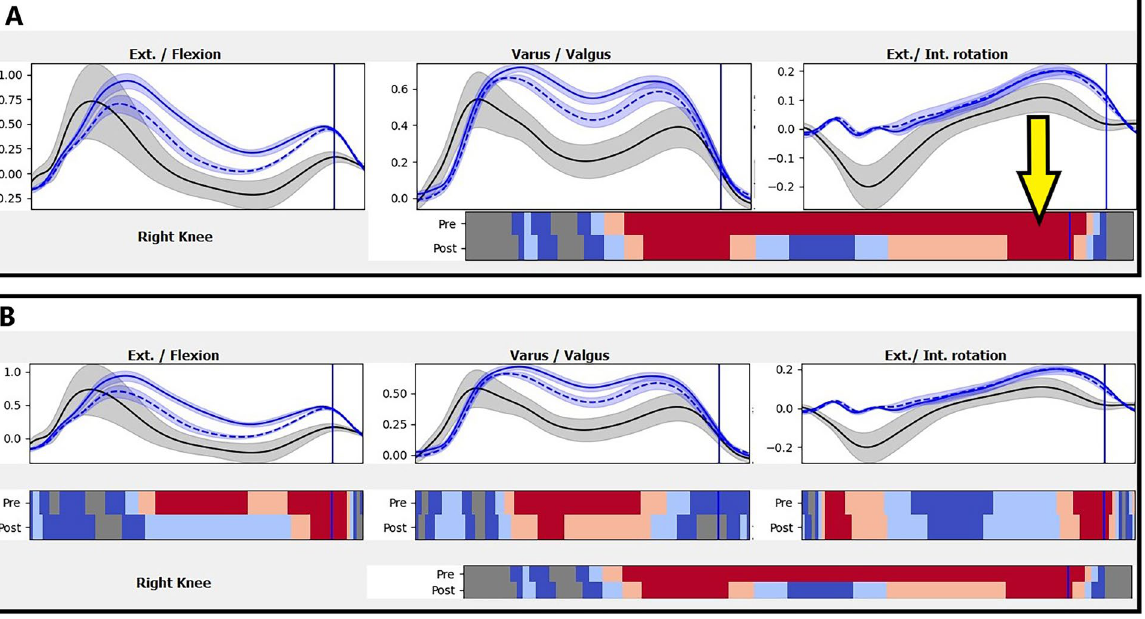
Figure 4. Close view of the right knee. ( A ) with hidden individual components. 1st row shows the recordings (reference, pre, and post intervention) in 3 dimensions. 2nd row shows the result of comparisons of both the preintervention vector (above) and postintervention vector (below) to the reference data vector, using Hotelling’s 2 test. The yellow arrow points to the 3D colormap bar. Clicking it will toggle the 3 individual components panels shown / hidden. ( B ) Same view of ( A ) after showing individual components. Upper and lower rows: as in ( A ), Middle row: Appearance of the result of comparison of individual components for both preintervention (above) and postintervention (below) to the reference data, using T test